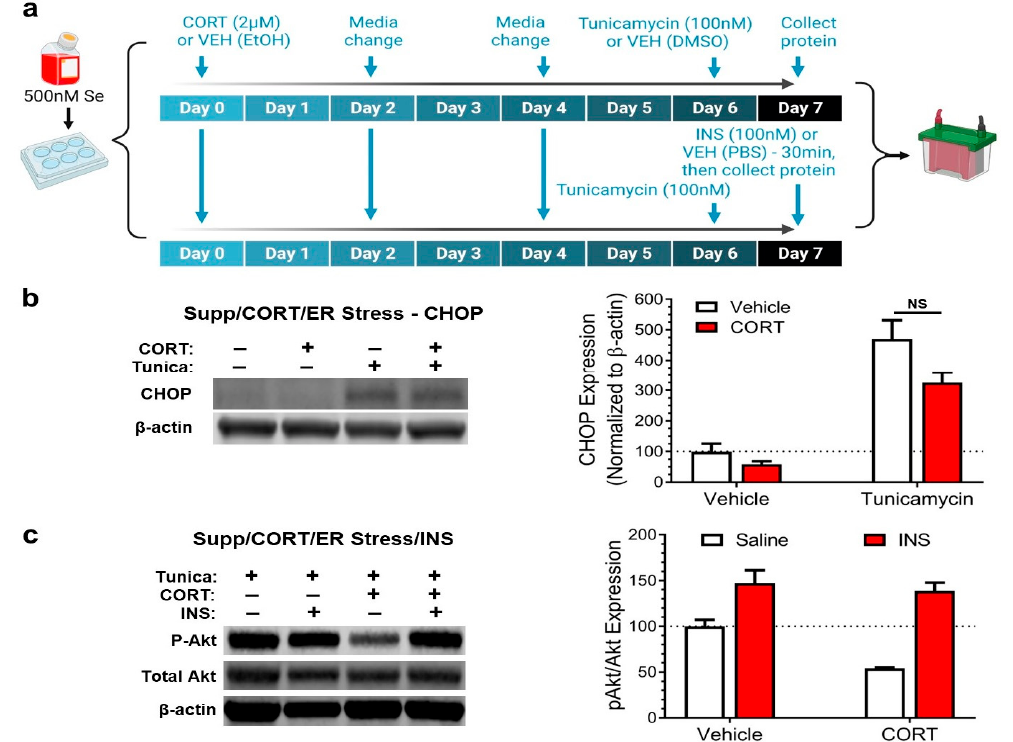
Figure 3. Supplementation with selenium has a restorative effect on endoplasmic reticulum stress and insulin signaling in corticosterone-exposed mHypoE-44 cells. ( a ) Experimental design: panel b: cells were treated with selenium (Se) supplementation (500 nM Se in media) in conjunction with either corticosterone (CORT) or vehicle (VEH; ethanol, EtOH) exposure, followed by endoplasmic reticulum (ER) stress induction using tunicamycin or addition of VEH (dimethyl sulfoxide, DMSO); panel c: cells were treated with Se supplementation in conjunction with either CORT or VEH, then all cells were exposed to tunicamycin, followed by either insulin (INS) or VEH (phosphate-buffered saline, PBS). ( b ) Culturing cells in media containing 500 nM Se prevented CORT from decreasing the potentiation of ER stress (two-way ANOVA: interaction: F(1,12) = 2.0, p = 0.2; Tukey’s: VEH/tunicamycin vs. CORT/tunicamycin: p = 0.07; n = 4 for all groups). ( c ) Supplementation with Se prevented CORT from worsening the impairment of INS signaling caused by ER stress (two-way ANOVA: CORT: F(1,12) = 8.9, p = 0.1; Tukey’s: VEH/INS vs. CORT/INS, p = 0.9; n = 4 for all groups). All values shown are mean ± standard error of the mean.